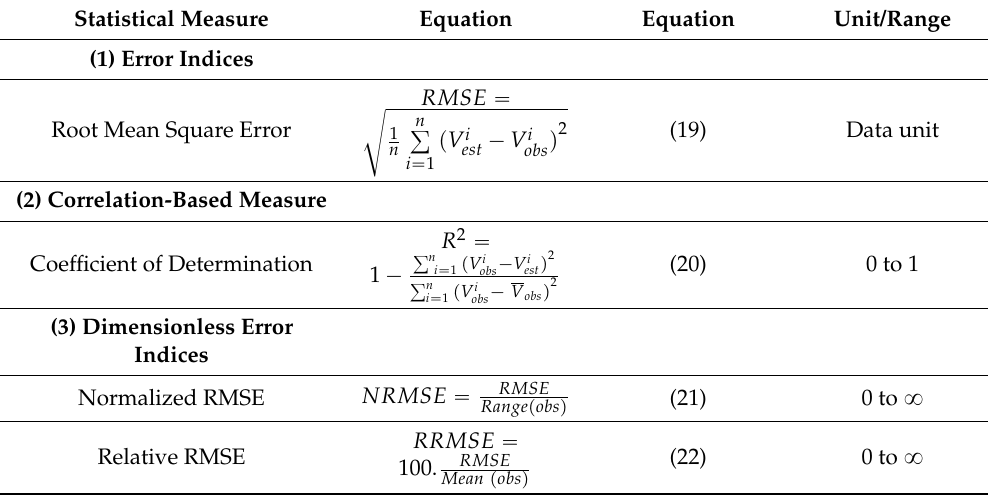
Table 3. Statistical measures used for evaluation of RTMo model inversion